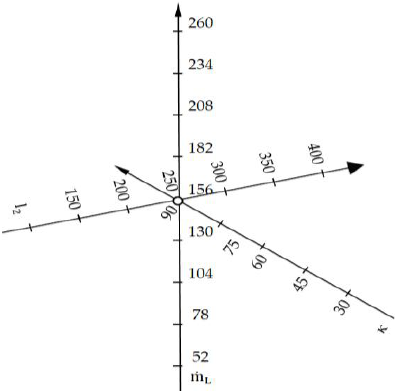
Figure 2. Graphical illustration of the test programme. Table 13. Measuring results of average surface paint coat stripping efficiency Q̅ F [m 2 ·h −1 ] from the surface of X5CrNi18-10 steel specimen as a function of the dry ice mass flow rate